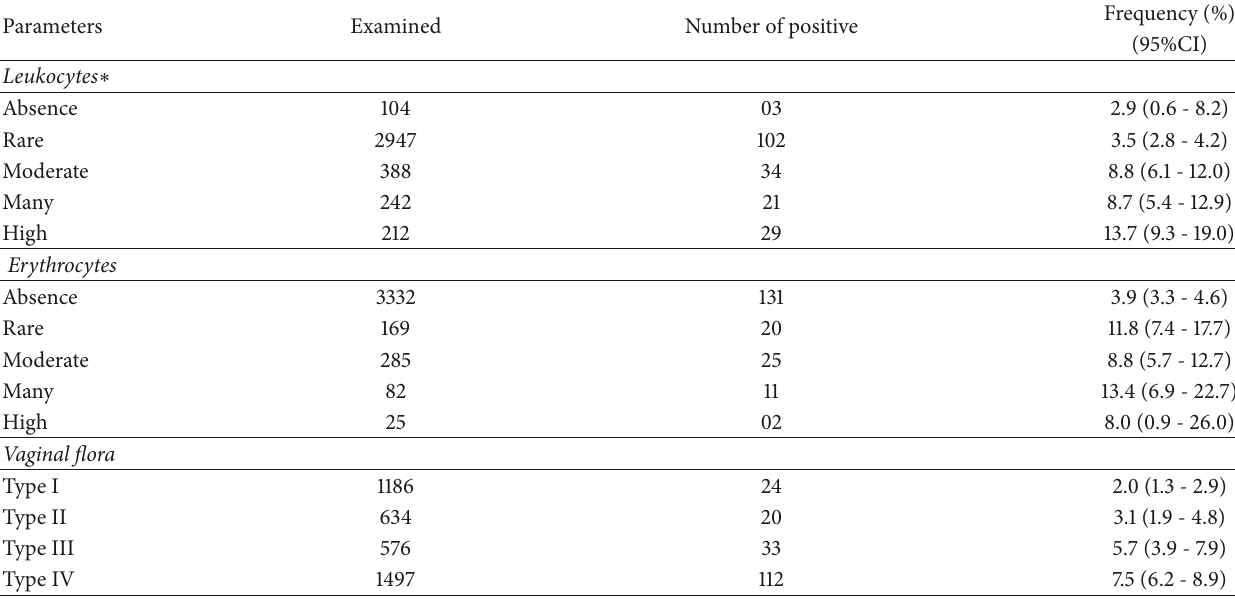
Table 4: Association between biological disorders and infection with Trichomonas vaginalis